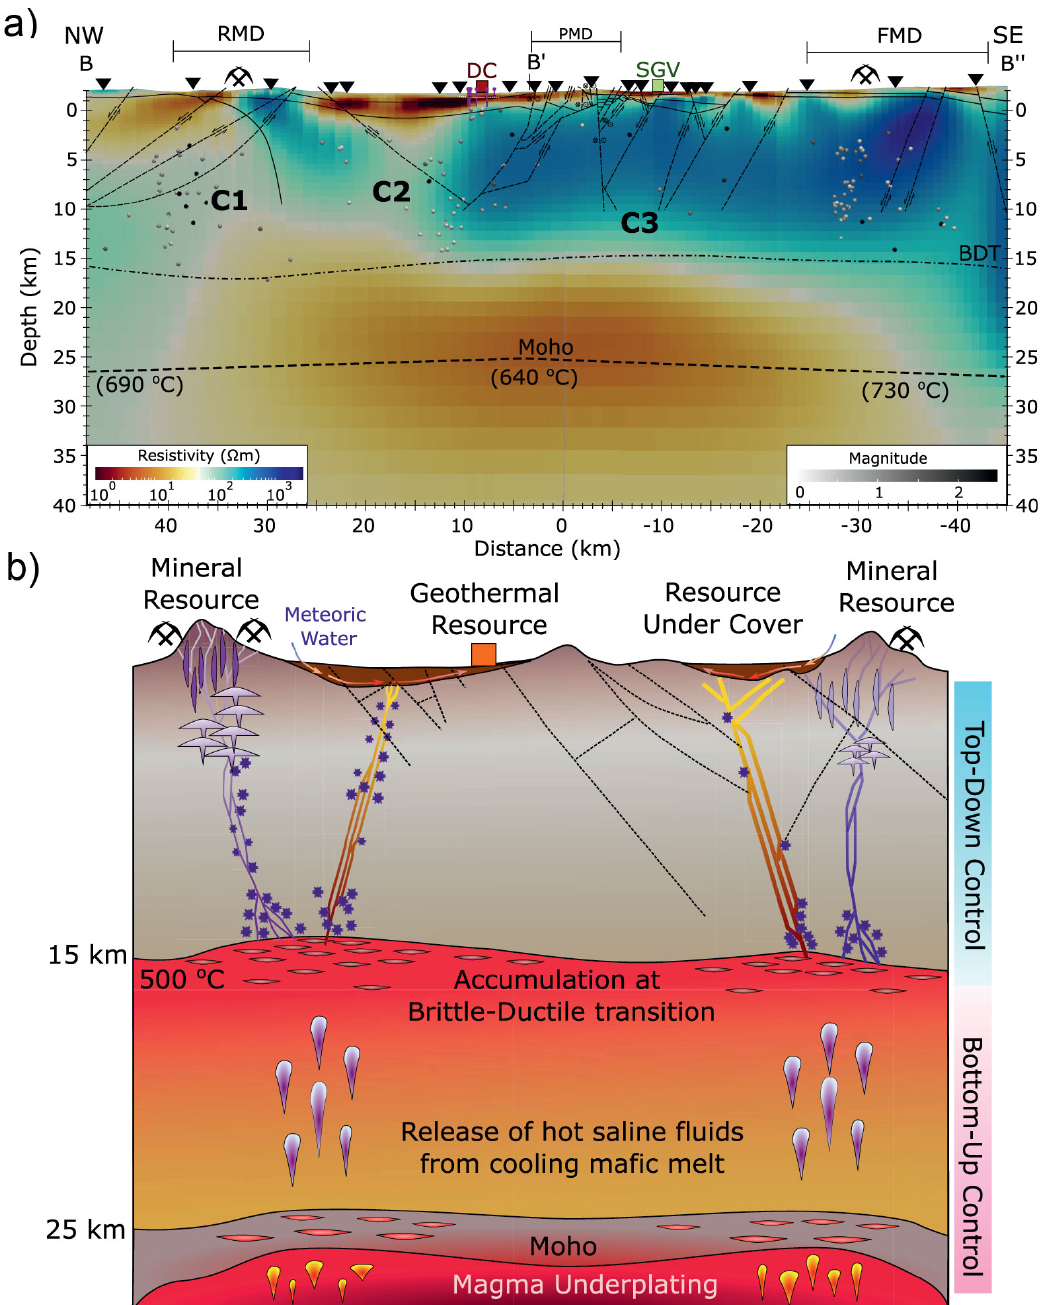
Figure 6. ( a ) A transect of electrical resistivity model extracted from 3D MT inversion at Gabbs Valley in the Great Basin, western United States and ( b ) the corresponding conceptual model after Peacock and Siler [34]. Dashed lines in the upper crust are faults inferred from structural geological data and spheres represent earthquake locations. C means conductor. RMD = Rawhide mining district; PMD = Poinsettia mining district; FMD = Fairplay mining district; DC = Don A. Campbell geothermal power plant; SGV = Southeastern Gabbs Valley geothermal area; BDT = brittle–ductile transition. Dashed lines in the upper crust are faults, squares are hydrothermal systems, triangles are MT sites, and pick and hammer are mineral